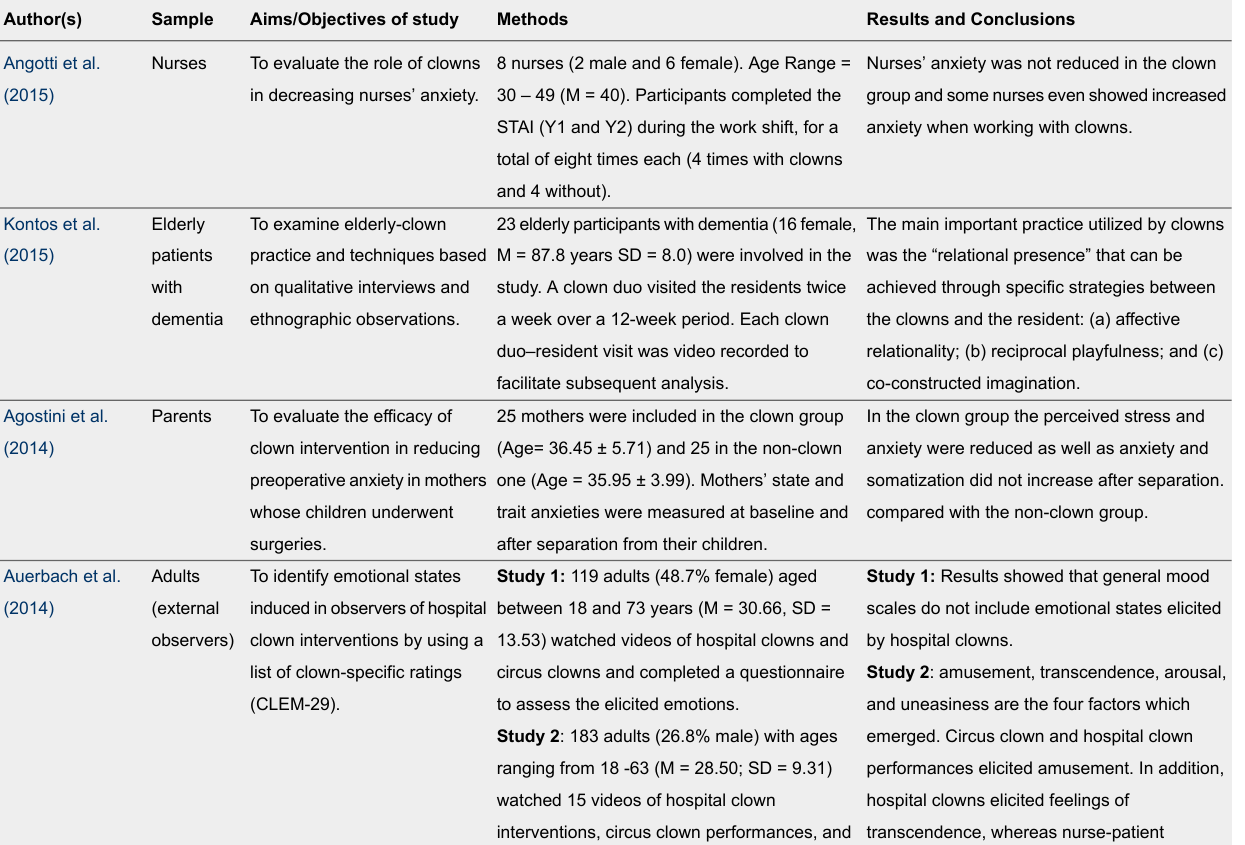
Details of the Reviewed Studies Chronologically